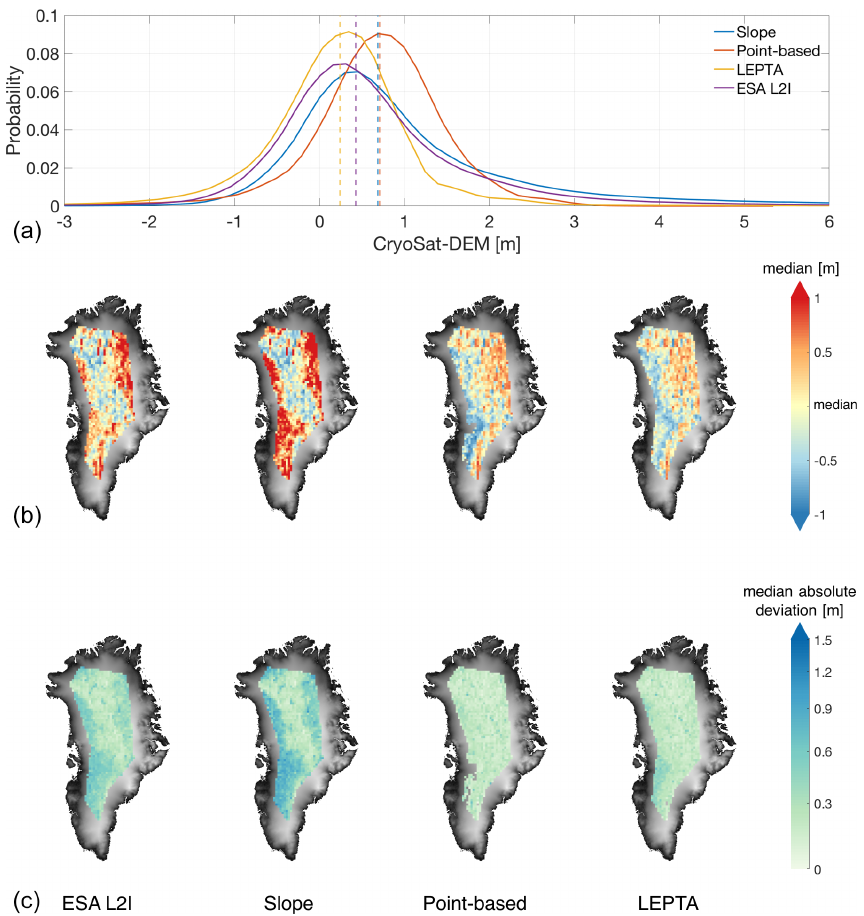
Figure 3. (a) Probability distribution of height difference between CryoSat-2 and the ArcticDEM, before removing the outliers with 10th and 90th percentiles. The probability distribution is plotted with all data samples but restricted to [ − 3m, 6m] for visualisation (for better illustration of the skewness and large outliers, please refer to Appendix B). Vertical lines show median value per method. (b , c) Spatial distribution of median and median absolute deviation of the height difference per tile of 25km × 25km, after removing the outliers. To enhance the visibility of the maps, the median value of each method is subtracted in (b) . The colours of the median absolute deviation plots are on a logarithmic scale to enhance contrast. The spatial distribution results from left to right are obtained by ESA L2I products, the slope method, the point-based method, and LEPTA, with the 1km × 1km DEM covering Greenland (Helm et al., 2014a, b) as